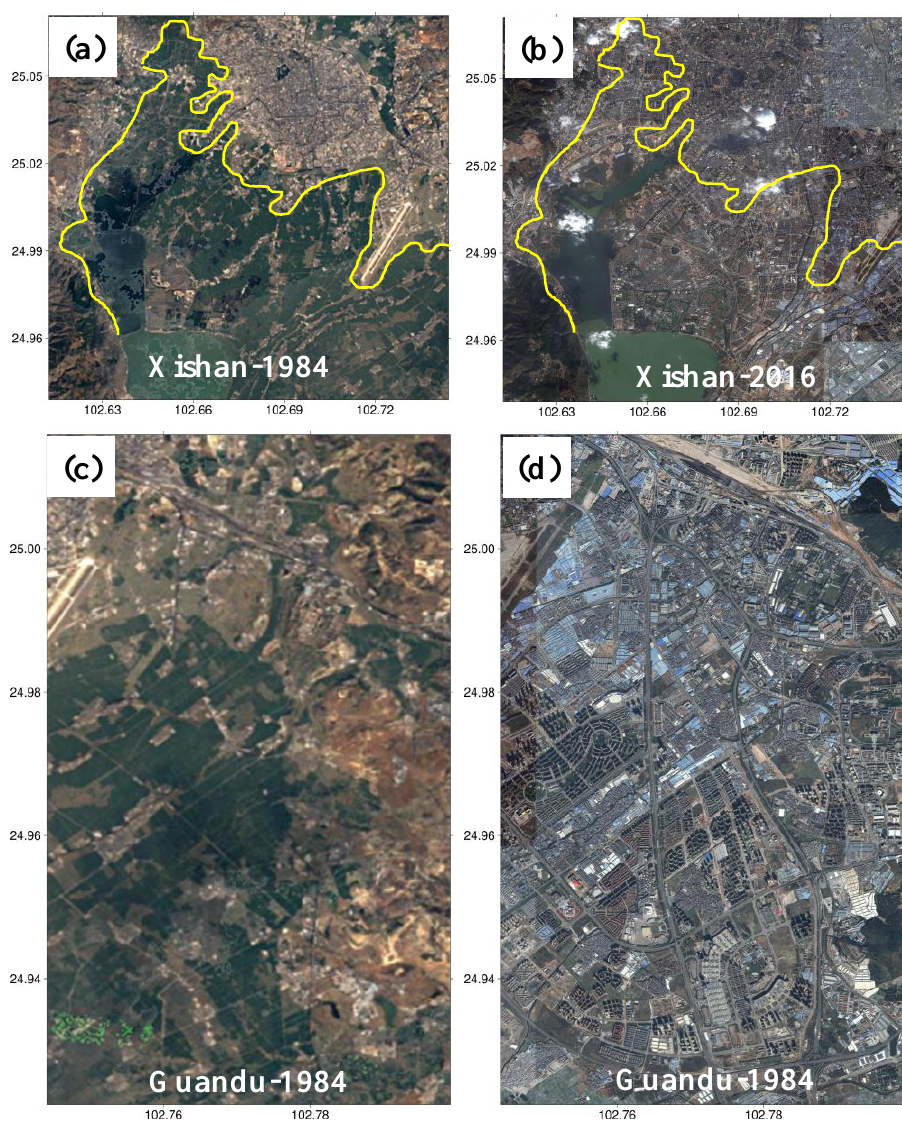
Figure 20. The changes in land cover over Xishan from ( a ) 1984 to ( b ) 2016, and over Guandu from ( c ) 1984 to ( d ) 2016.